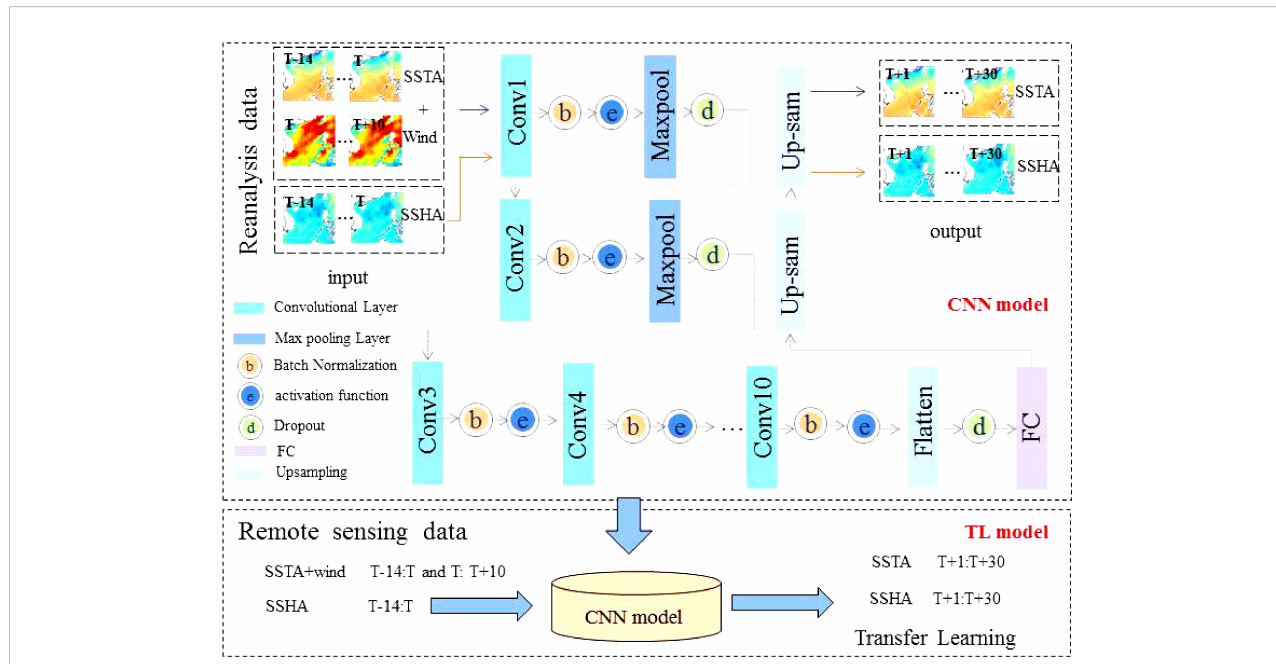
FIGURE 3 Structure of the CNNTL model. This model is composed of ten convolutional layers, ten BN layers, two max pooling layers, one fully connected layer and two upsampling layers.